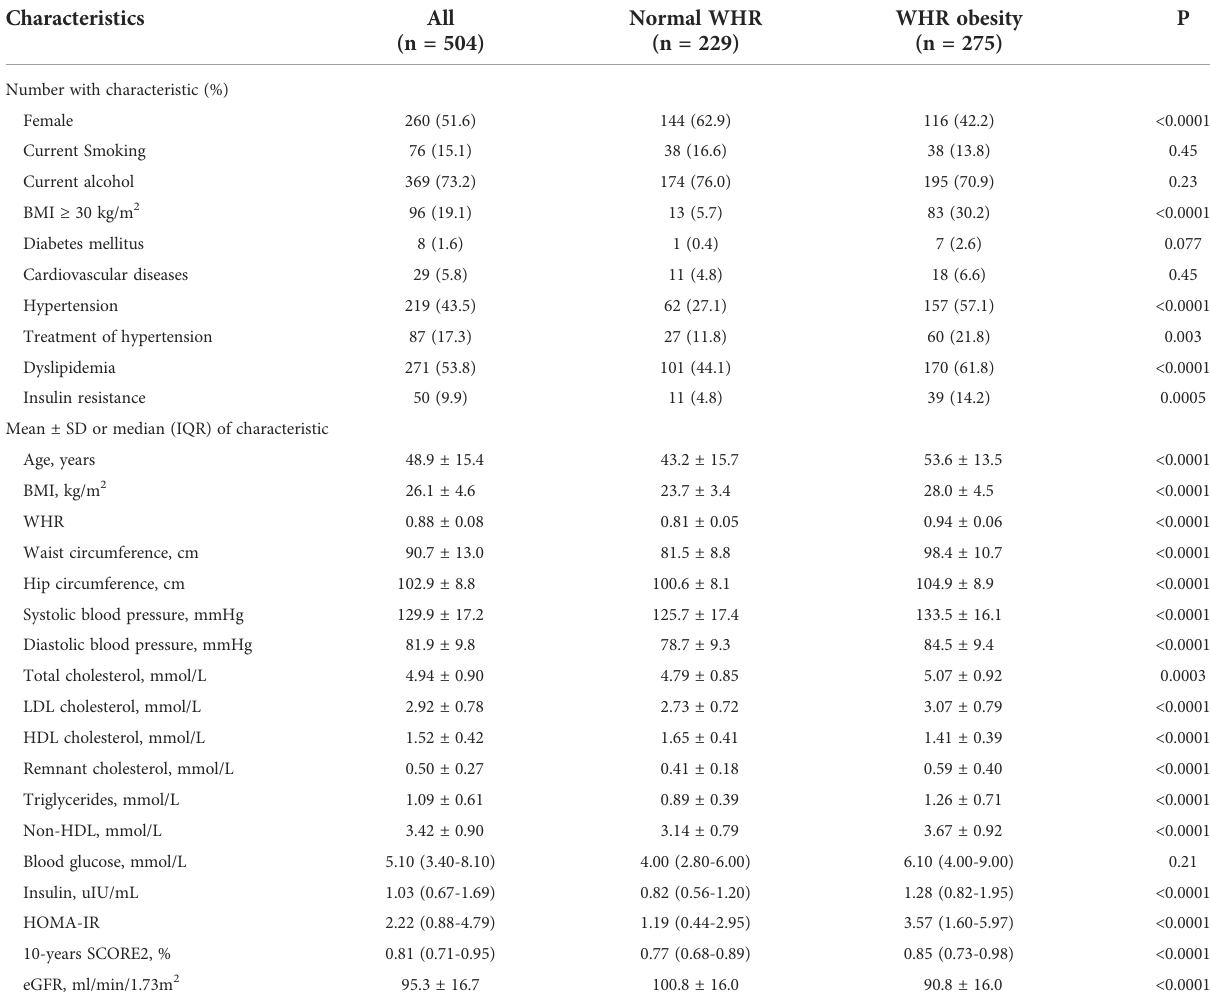
TABLE 1 Participant